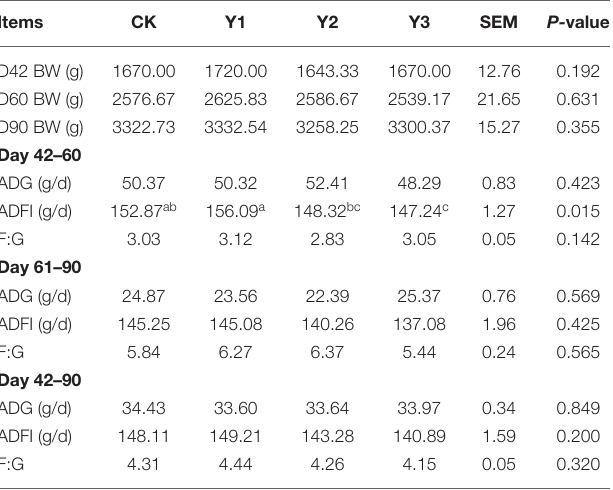
TABLE 2 | Effects of dietary AOE on growth performance in ducks. (17). Briefly, ∼ 0.5 g of breast muscle samples were weighed and mixed with 8 ml of acid solution (HNO 3 : H 2 O = 5: 95) in 50 ml digestion tubes, then kept at room temperature overnight.